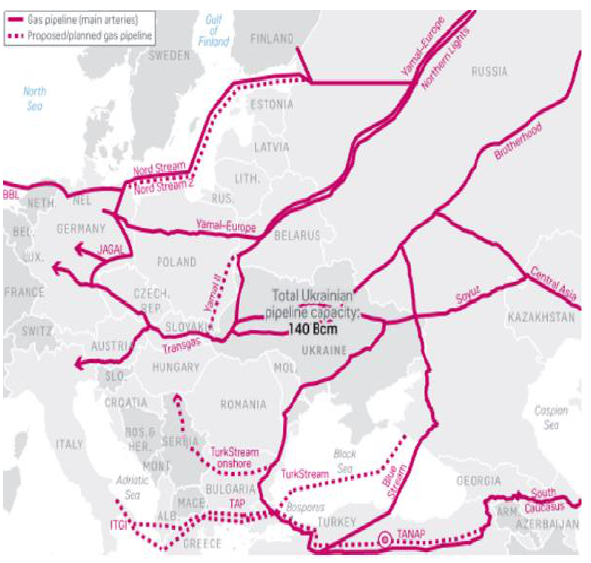
Figure 2. Pipelines from Russia [22] (p. 5). Reprint with permission [22], 2019, Jacques Delors Energy Centre.